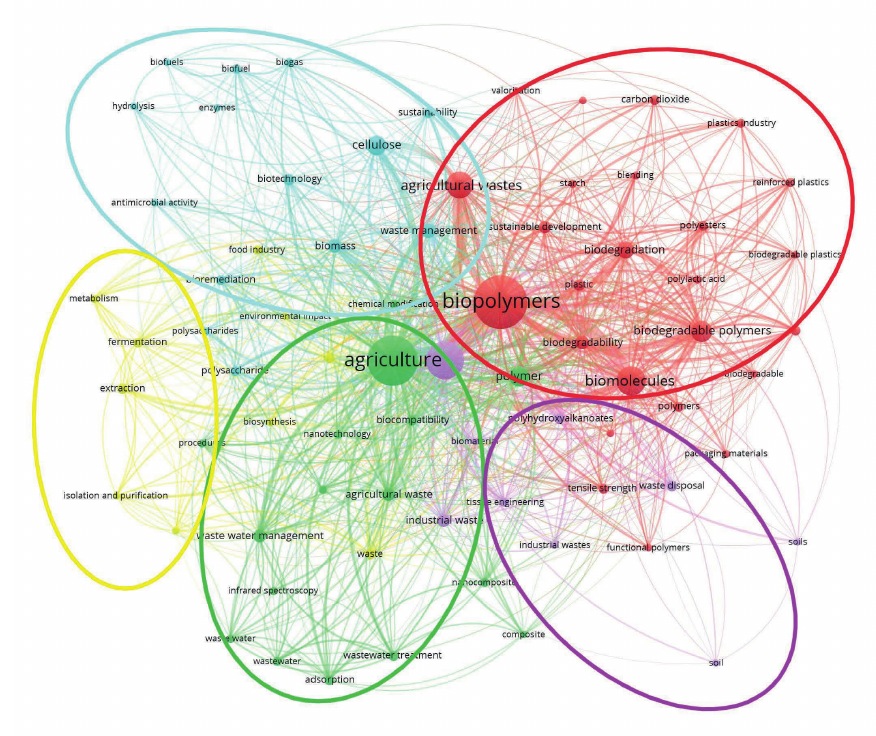
Fig. 6. Visualization of co-occurrences for keywords ‘agriculture’ and ‘waste’ and